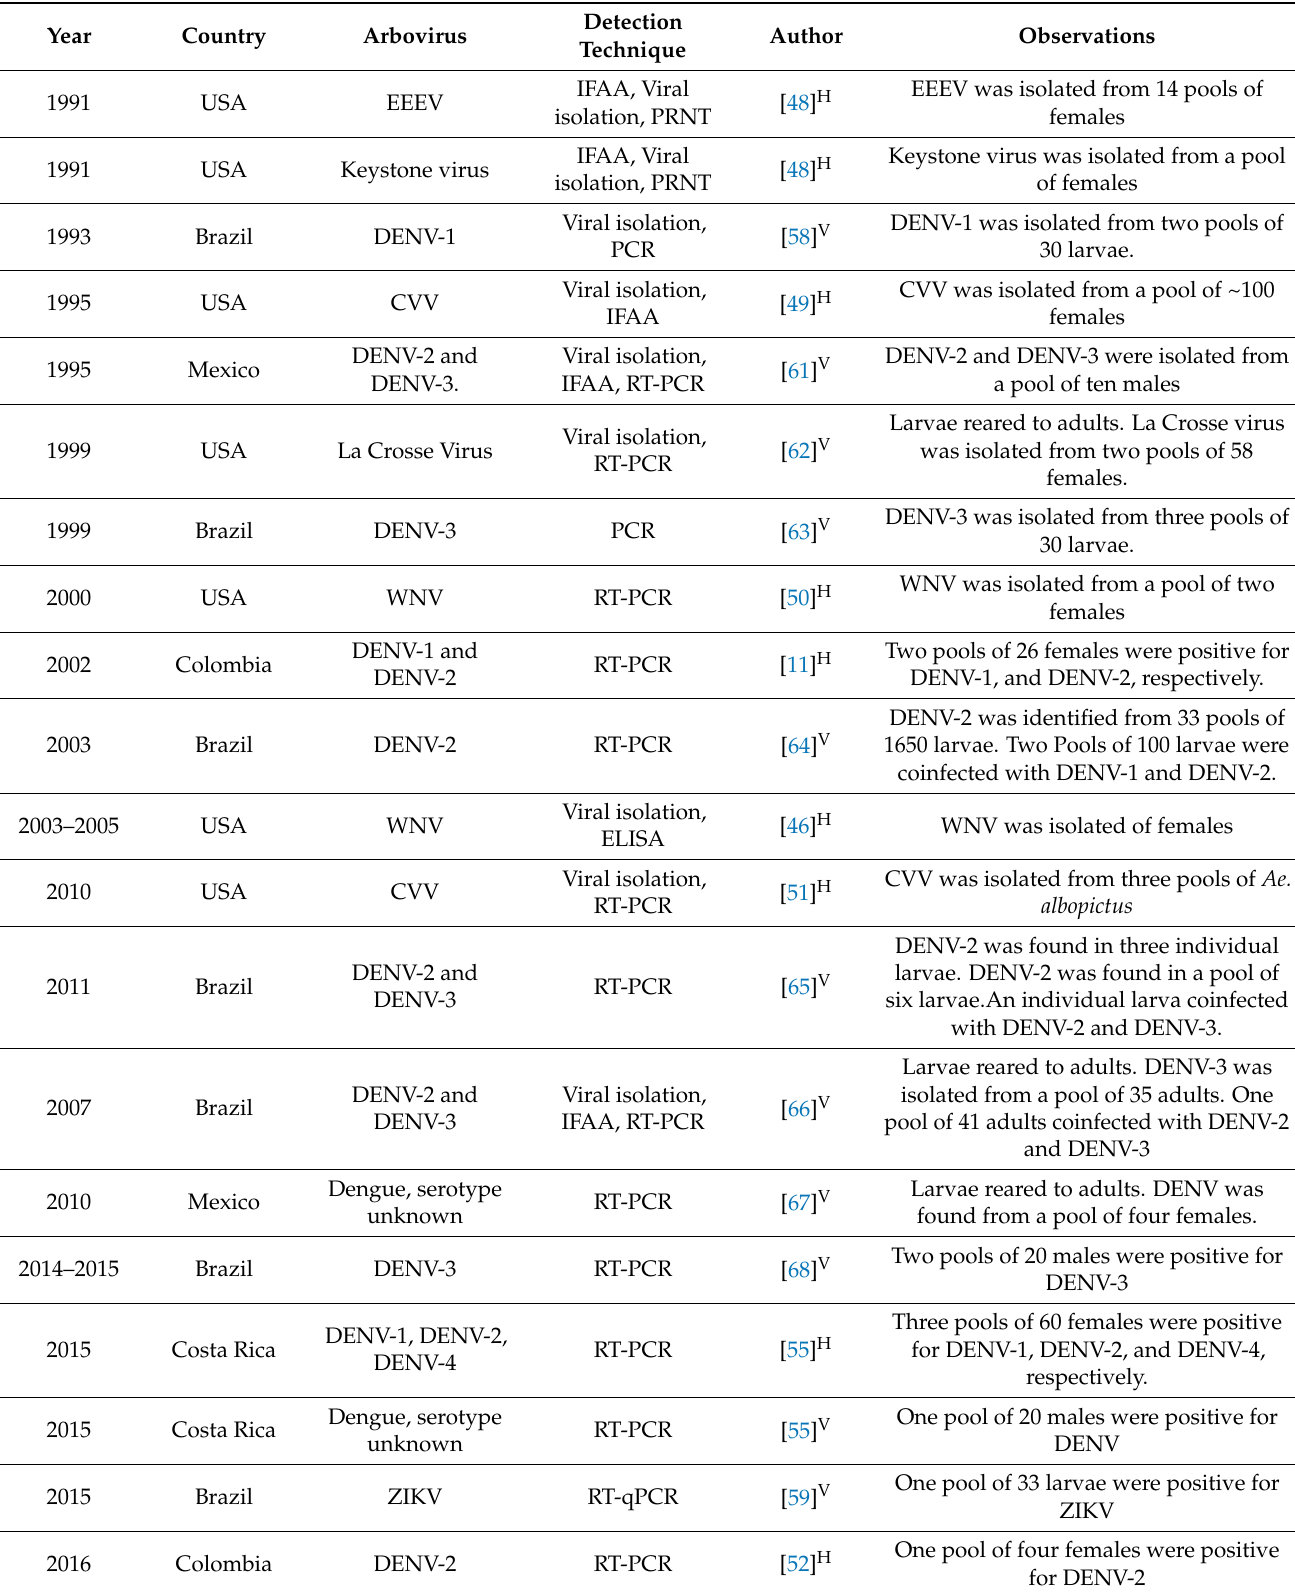
Table 3. Chronological summary of publications on natural infection of Ae. albopictus with arboviruses of medical and veterinary